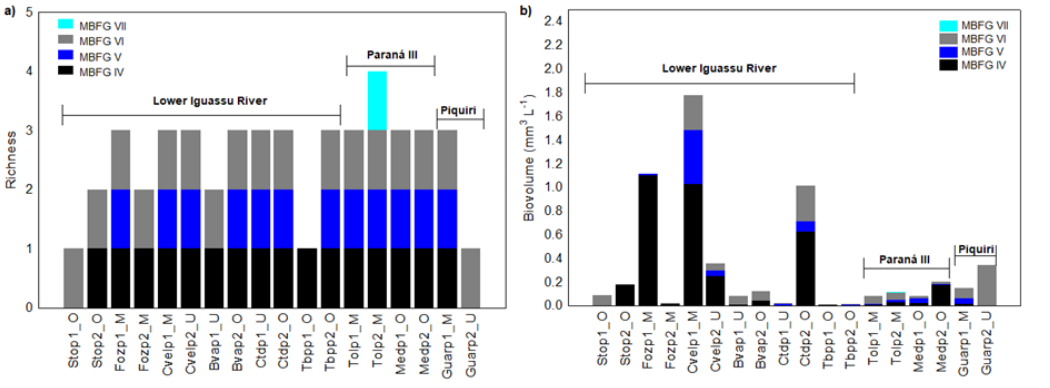
Figure 4. (a) MBFG richness and ( b) MBFG biovolume (mm 3 L -1 ) in rivers from different river hydrographic basins in western Paraná, Brazil (1- headwaters; 2 – water catchment point; O – oligotrophic; M – mesotrophic; U – ultraoligotrophic).